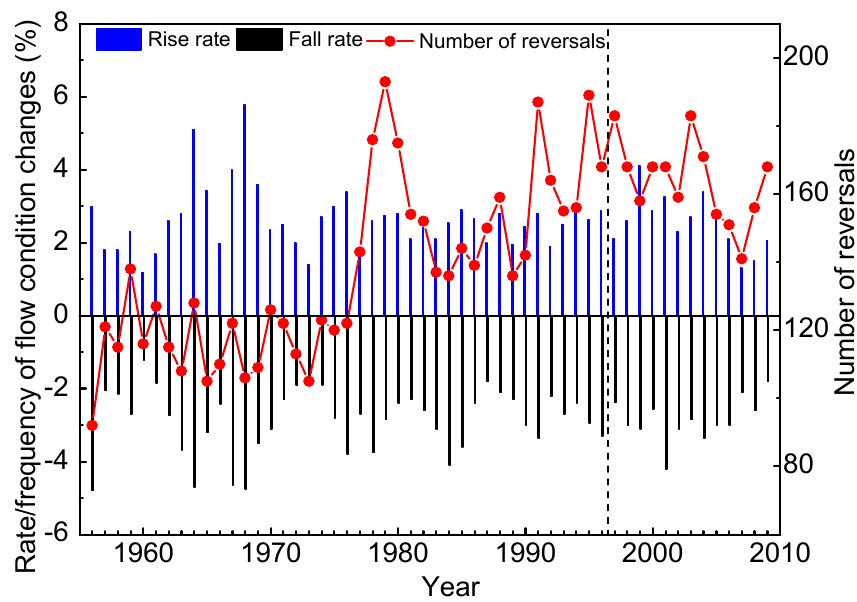
Figure 7. Rise rate, fall rate and number of reversals at Zhangjiashan Station (the outlet of the Jinghe Basin).